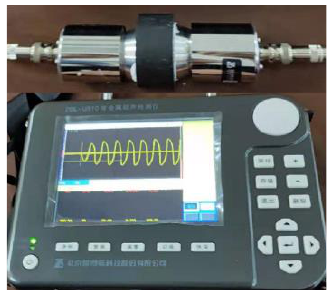
Figure 2. U510 non-metallic ultrasonic detector.